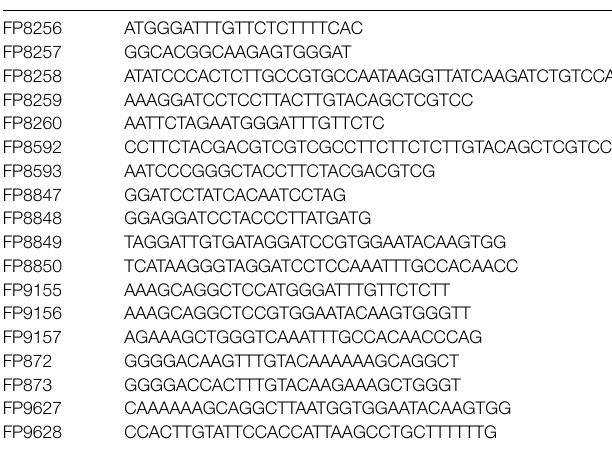
TABLE 1 | Primers used in this